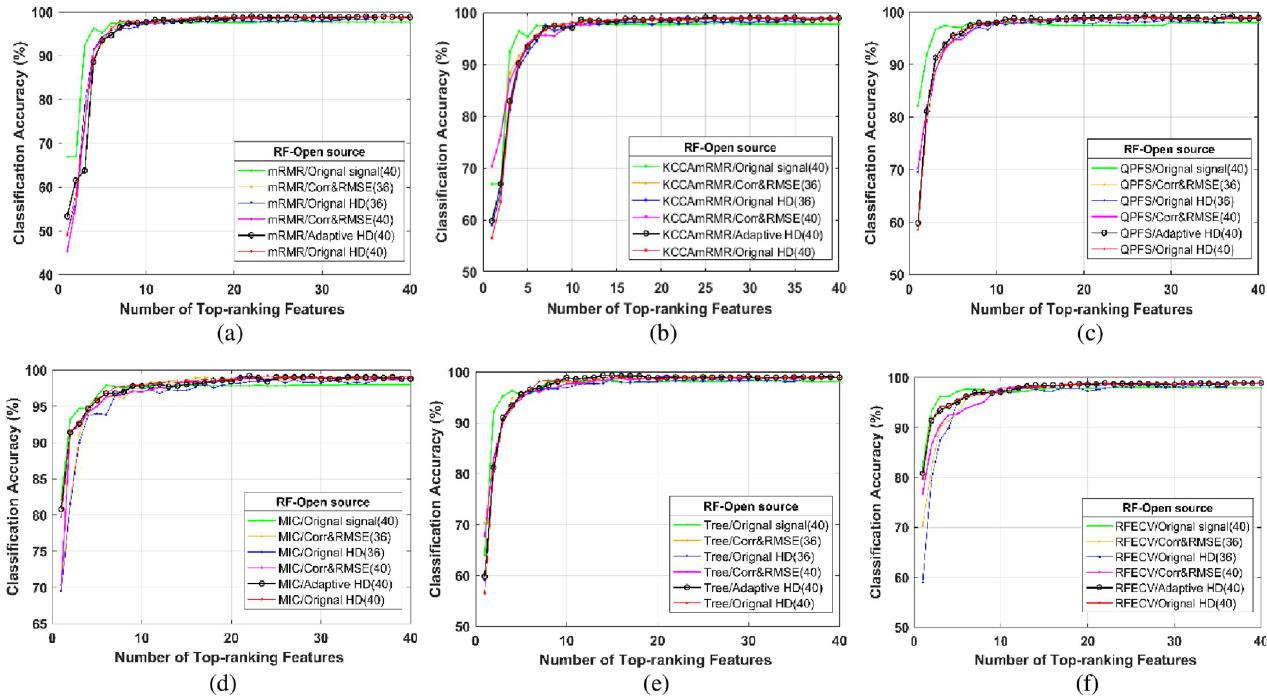
Fig 9. The average classification accuracy versus the number of top-ranking features selected by mRMR, KCCAmRMR, QPFS, MIC and Tree and RFECV using RF classifier from open source data.